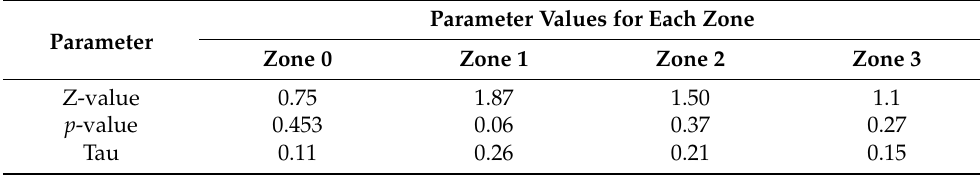
Table 6. Area Calculation for the Representative Years When Population Density is Considered.